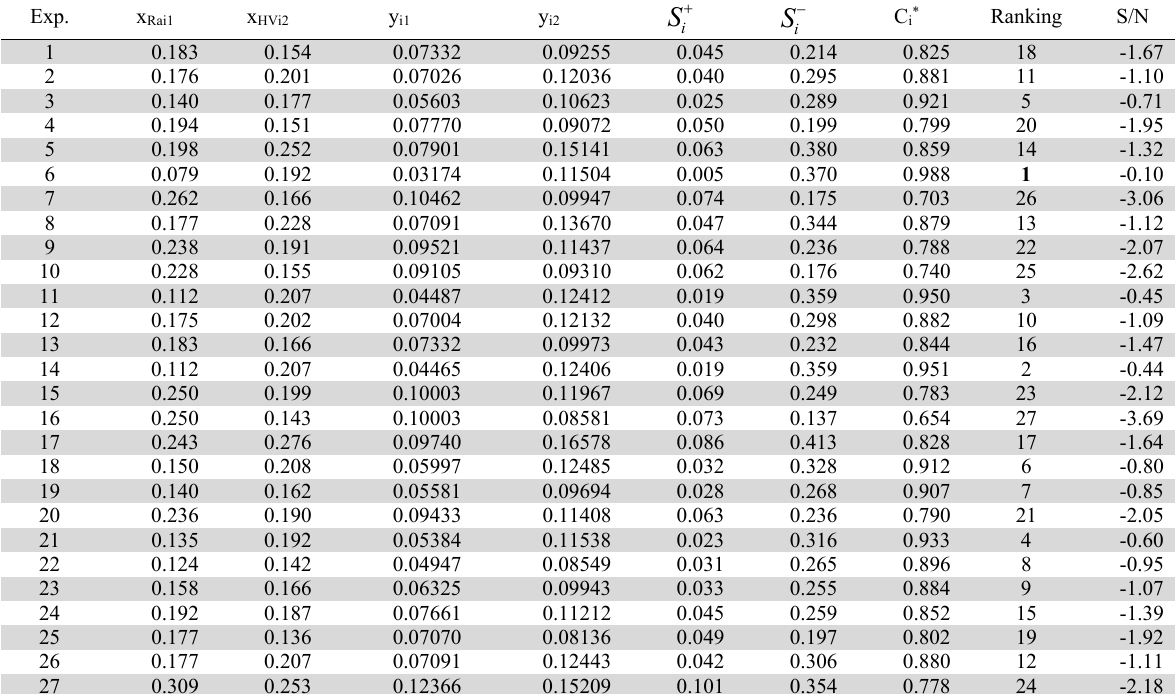
The conversion value calculated from step 3 to step 7 Exp.